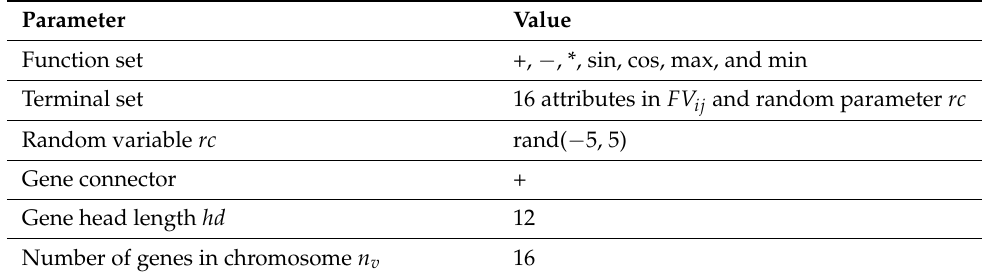
Table 3. The variables in the